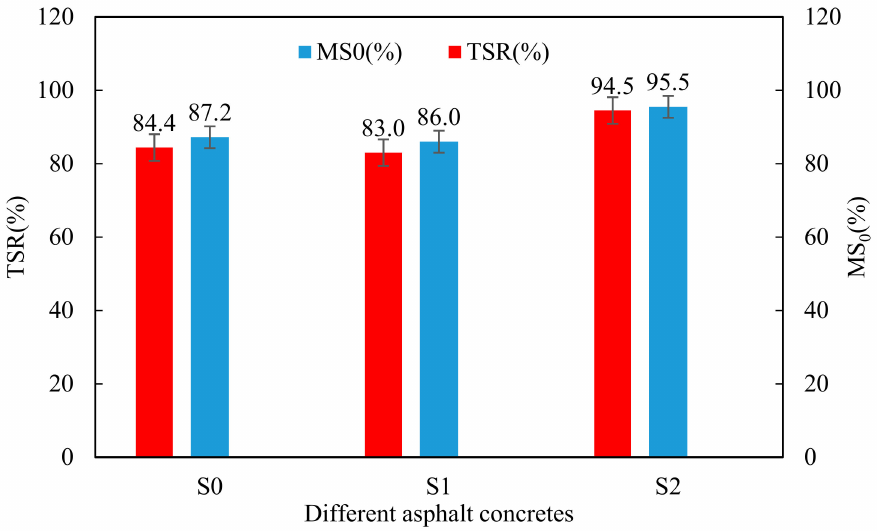
Figure 9. MS 0 and TSR of different asphalt